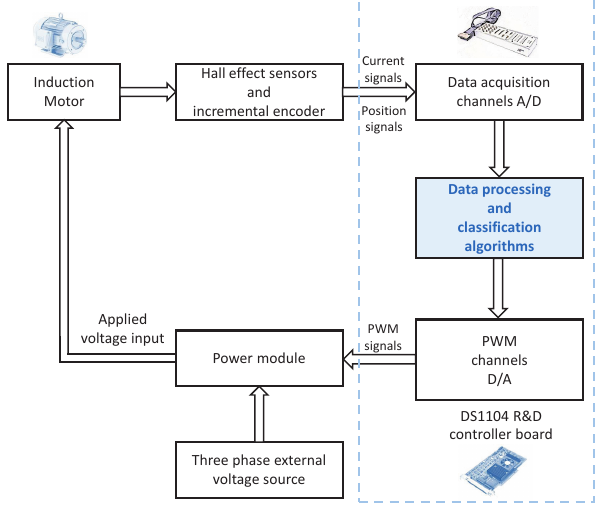
Figure 1. Rotatory induction motor test bench configuration for sensor fault classification.